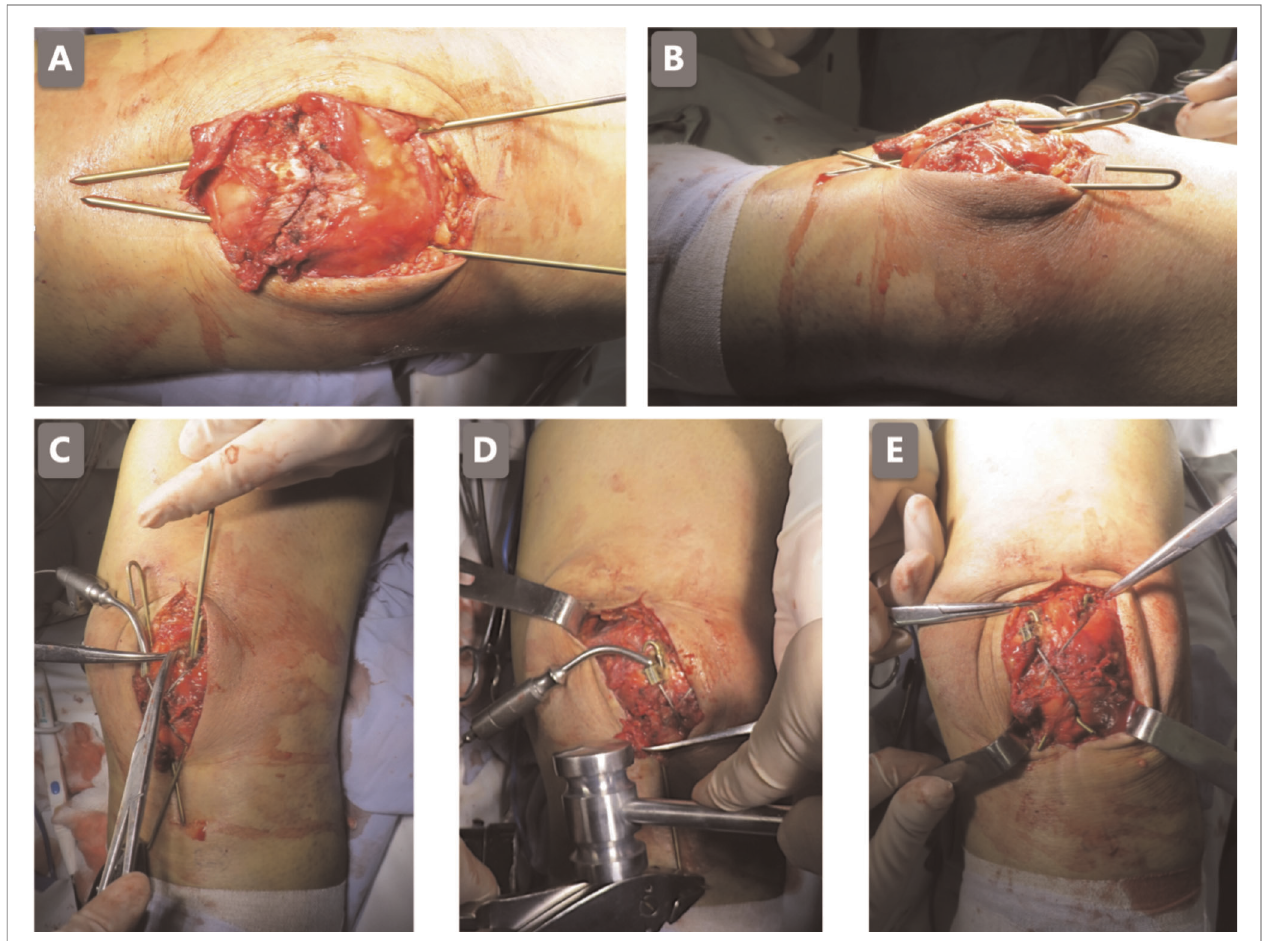
FIGURE 1 | The patellar was fi xed with two titanium K-wires with a titanium cable ( A ); the proximal K-wires were bent to 180° ( B ); the holes in the superior extreme of the patellar were drilled next to the bent part of the K-wires ( C ); the K-wires were knocked into the holes ( D ); the 1-mm titanium cable was placed as a fi gure-of-eight pattern ( E